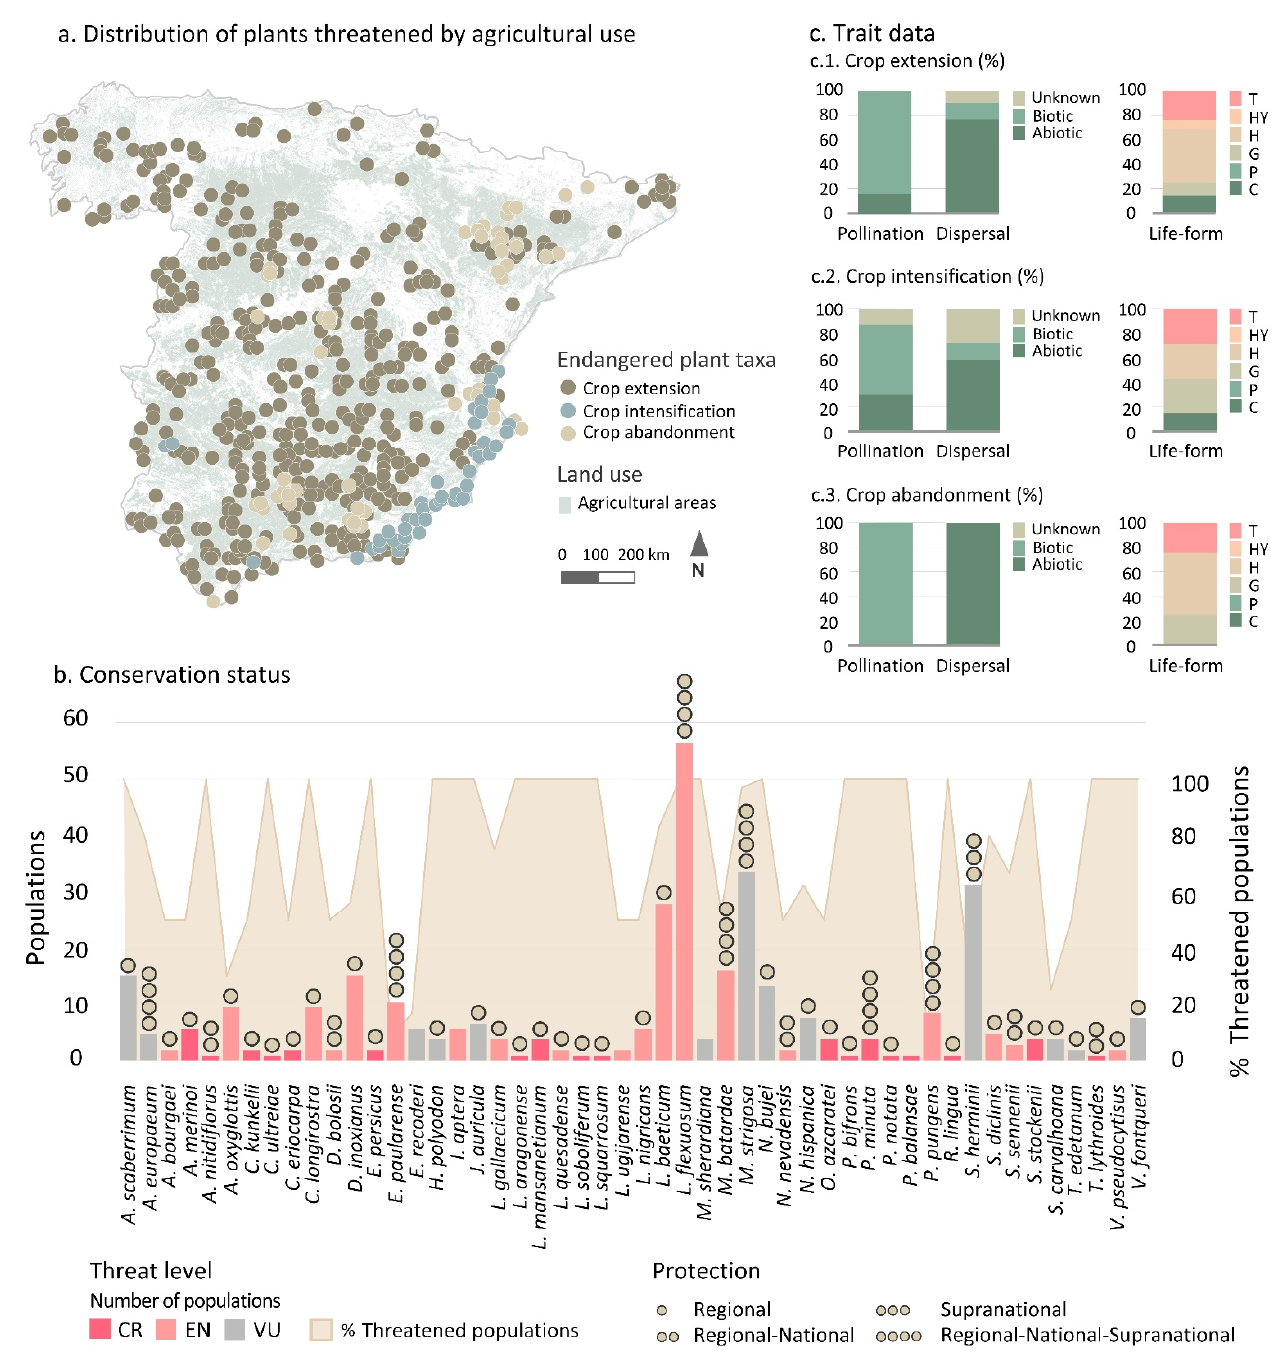
Figure 1. Summary of plants threatened by agricultural use in continental Spain, their conservation status, and functional traits. ( a ) Distribution of plants threatened by agricultural use. Map of the presence of taxa threatened by agriculture included in each category (represented in three different colors) and base map with the area of agricultural use present in the study area. ( b ) Conservation status. The graph shows the taxa identified as threatened by agricultural use; the height of the histogram bar shows the number of populations (values indicated on the left axis), the color of the bar shows the threat category (CR, EN, VU) and the brown area shows the percentage of threatened populations (values indicated on the right axis). In addition, the level of protection is indicated by circles on the histogram bar (1, regional; 2, regional-national; 3, supranational; 4, regional-national-supranational). ( c ) Trait data. Plant trait includes for each threat category ( c1 – c3 ): % pollination mode (unknown; abiotic; biotic); % dispersal mode (unknown; abiotic; biotic); and % life form (C, chamaephytes; G, geophytes; H, hemicryptophytes; Hy, hydrophytes; P, phanerophytes; T, therophytes).